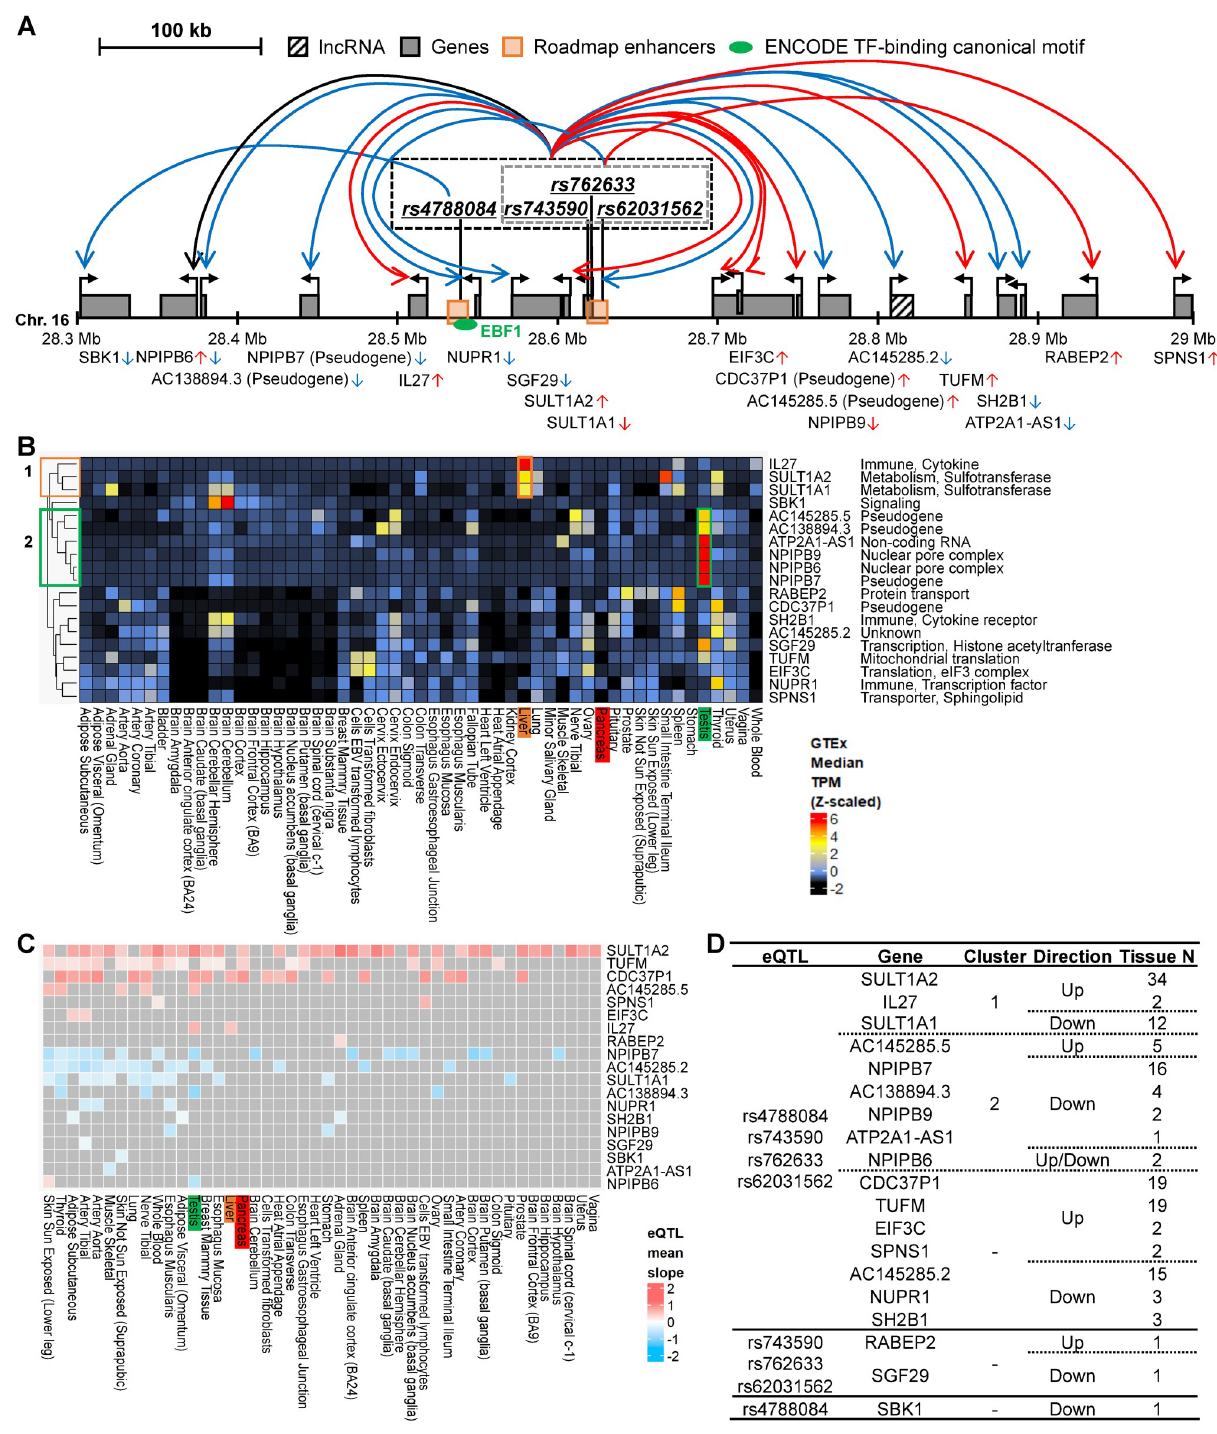
Fig 3. Complex transcriptional regulatory circuits in the 16p11.2 locus. A . This diagram shares the same rules for color, shape, and arrows as Fig 2. Regulatory circuits of the four T1D-associated eQTLs (rs4788084, rs762633, rs743590, and rs62031562) and their 19 associated genes. The four eQTLs share a common direction of association with 16 of the 19 genes. Two of the genes, SGF29 and RABEP2 , are associated with three of the eQTLs, rs762633, rs743590, and rs62031562. The expression of SBK1 is associated only with rs4788084. The enhancer region harboring rs4788084 contains a canonical binding motif for the TF EBF1. B . Relative gene expression levels of the 19 genes are displayed as a heatmap. By hierarchical clustering, two representative groups were found with high tissue-specific expression patterns. The genes highly expressed in each organ are marked with colored boxes